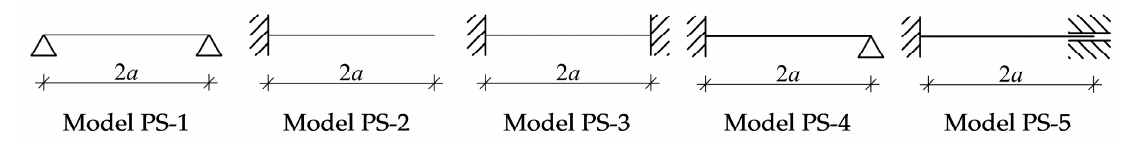
Figure 12. Models of the tensegrity plate